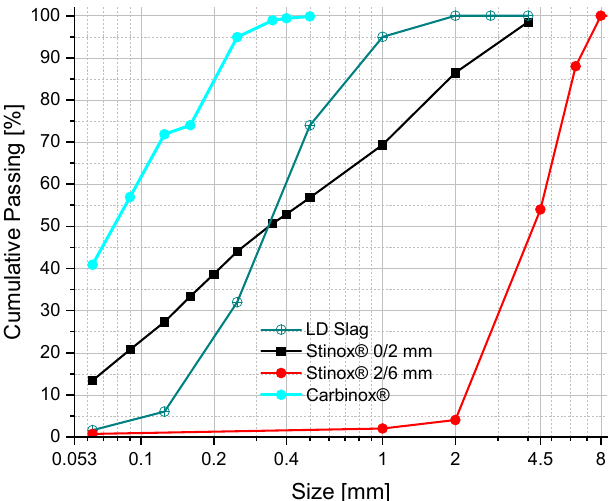
Figure 1. Particle size distribution of Carbinox ® , LD Slag, Stinox ® 2/6, and Stinox ® 0/2 obtained using Sieve analysis.